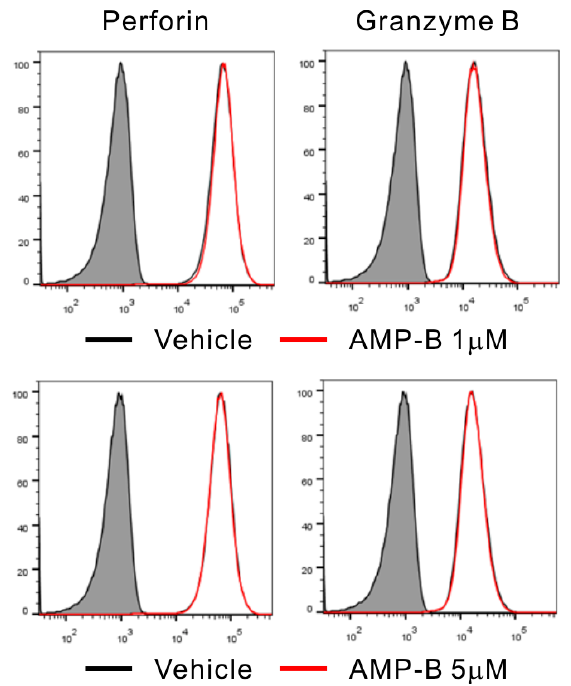
Figure 5. Effect of AMP-B on the expression of perforin and granzyme B in NK cells. Representative flow cytometry profiles showing the expression of the perforin ( left ) and granzyme B ( right ) in NKL cells after incubation with 1 µM ( upper ) or 5 µM ( bottom ) of AMP-B for 3 h ( red solid line ), or with vehicle only (black solid line). Isotype control staining is shown as a shaded histogram. Shown is a representative of two independent